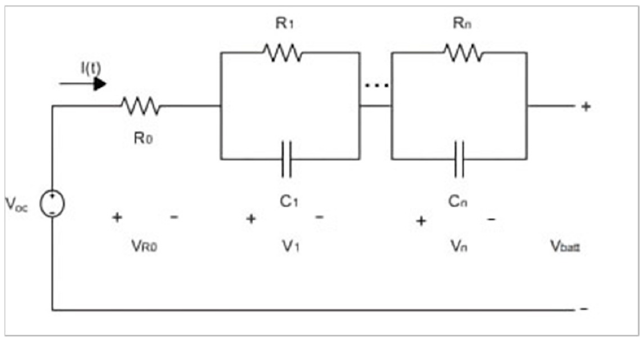
Figure 1. Equivalent circuit model.